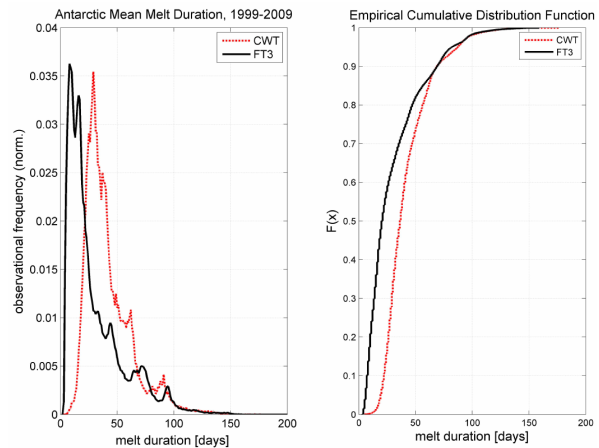
Fig. 4. (a) A histogram of all observed seasonal melt duration in days for the years 2000 through 2009 for the wavelet-based melt detection method (CWT) and a fixed-threshold method (FT3). It is found that the observations for the CWT are shifted towards longer durations due to the exclusion of short-duration melting events. (b) An empirical cumulative density function of observed melting